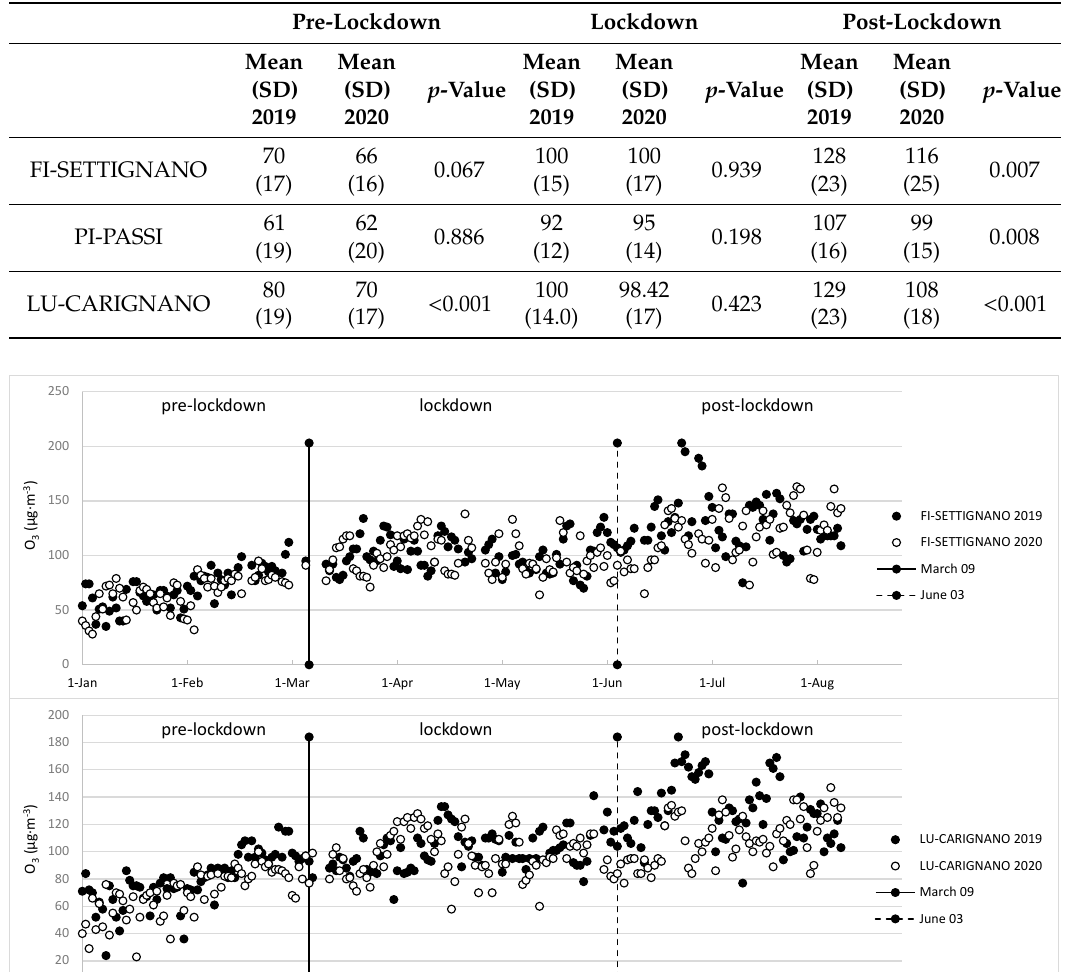
Table 6. Output of the two-sample t -test to evaluate the e ff ects of lockdown on O 3 air concentrations. The O 3 values are expressed in µ g · m − 3 .